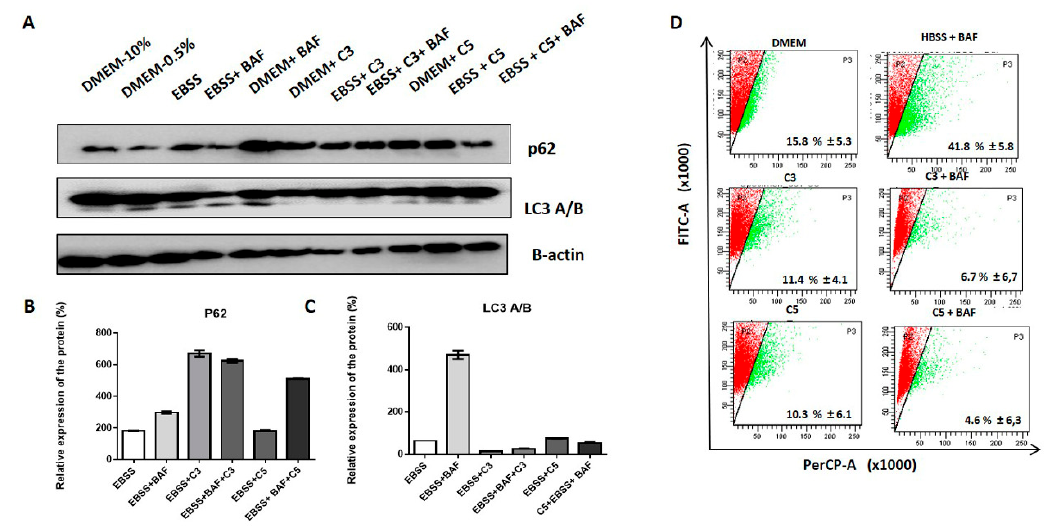
Figure6. Analysis of the involvementof A. coriacea fractions in autophagy. ( A ) Analysis of theexpression of proteins involved in the autophagic flux in SiHa cells. ( B ) Densitometry of p62. ( C ) Densitometry of LC3 B / A (Microtubule-associated protein 1A / 1B-light chain 3). ( D ) Acridine orange staining in SiHa cells. There was a reduction in the percentage of formation of acid vesicles, evidenced by a reduction of the fluorescent green signal after treatment with the fractions ( p < 0.05). HBSS: Hank’s balanced salt solution; EBSS: Earle’s balanced salt solution; C3: Ethyl acetate fraction; C5: Fraction enriched in acetogenin; Cis: cisplatin. BAF: